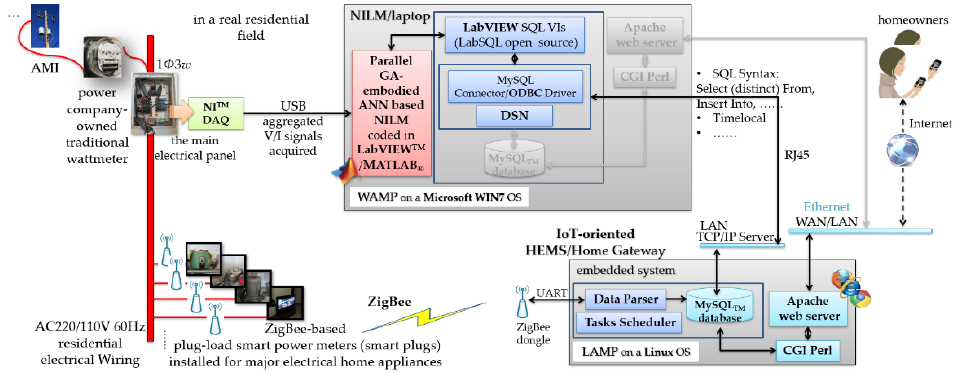
Figure 1. Block diagram of the home energy management system (HEMS) [24] having the developed parallel GA-embodied artificial neural network (ANN) for non-intrusive load monitoring (NILM).